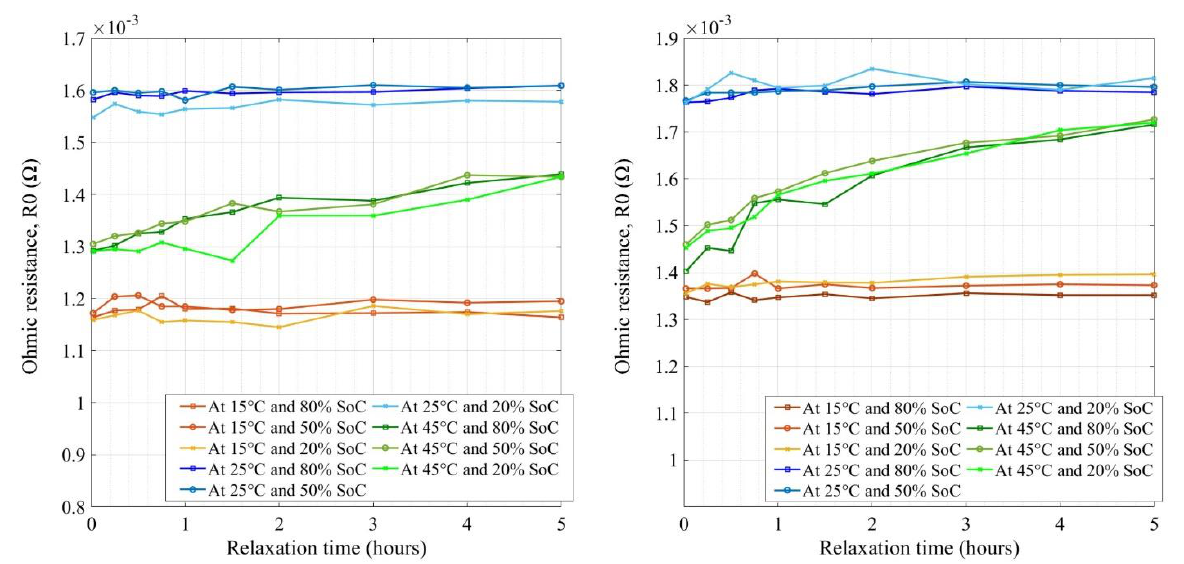
Figure 10. Ohmic resistances for new ( left ) and aged ( right ) LTO cells.